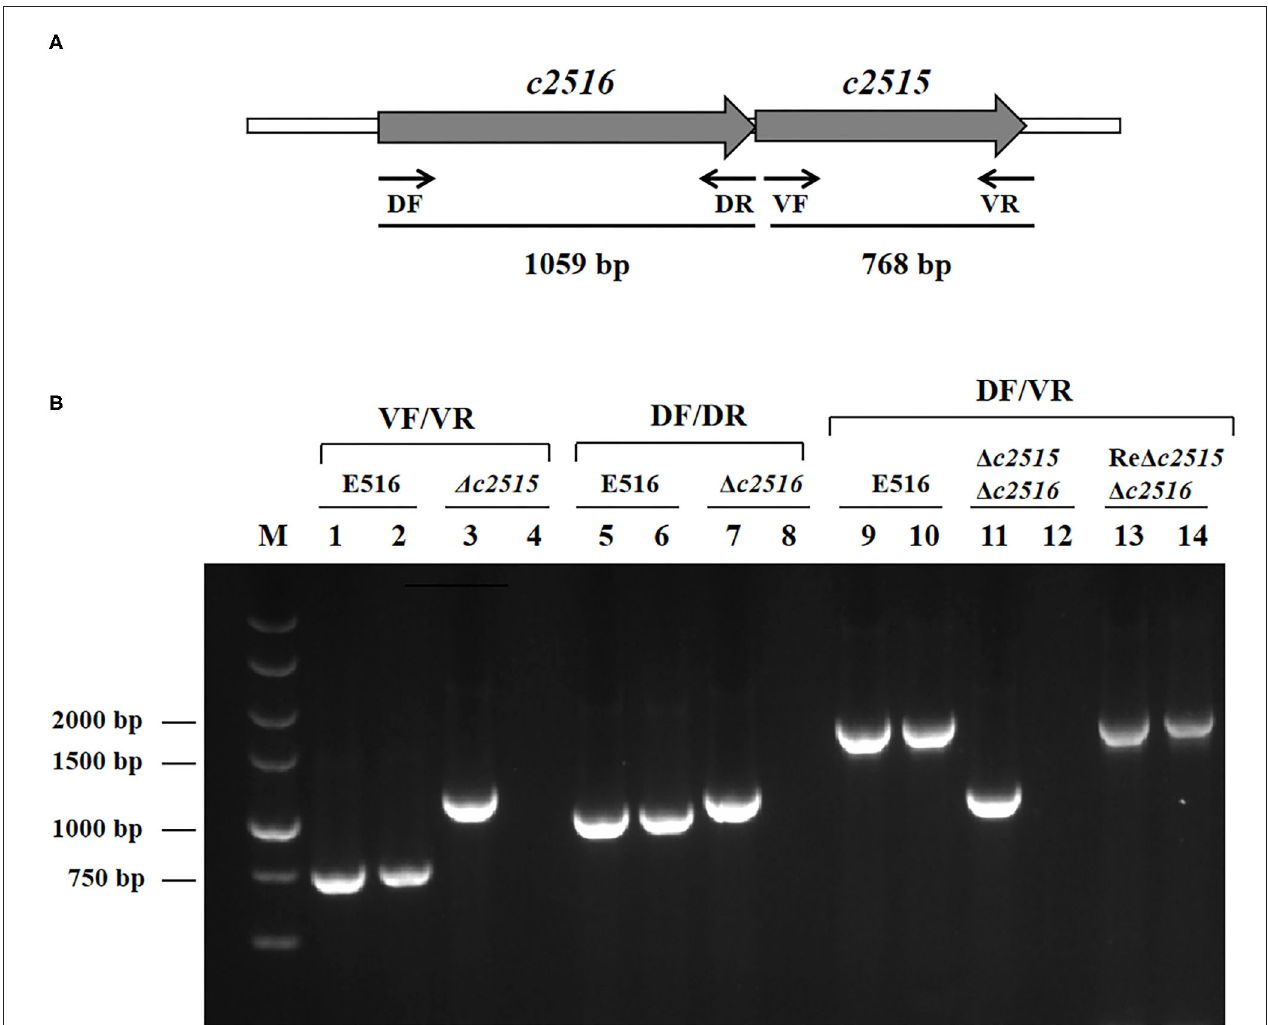
FIGURE 1 | (A) Genetic organization of the c2515 and c2516 loci in the APEC E516. Large arrows represent the direction of transcription, and the sites of primers used for detection are indicated with small arrows. (B) Detection of target genes transcription by RT-PCR. Templates: lanes 1, 5, 9: genomic DNA from E516; lanes 2, 6, 10: cDNA derived from total RNA of E516. Lanes 3, 7, 11, 13: genomic DNA from 1 c2515 , 1 c2516 , 1 c2515 1 c2516 , Re 1 c2515 1 c2516 , respectively. Lanes 4, 8, 12, 14: cDNA derived from total RNA of 1 c2515 , 1 c2516 , 1 c2515 1 c2516 , Re 1 c2515 1 c2516 , respectively. Target genes: Lanes1–4: c2515 ; Lanes 5–8: c2516 ; Lanes 9–14: c2516c2515